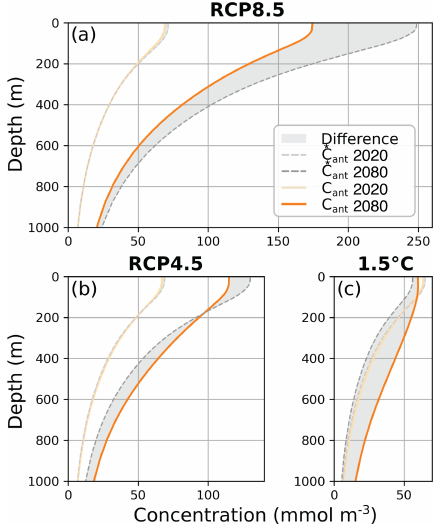
Figure 3. CESM global-mean anthropogenic carbon profiles ∗ C ant (z) (gray, dashed), for ( C ant (z) ) (orange, solid) and profiles of the (a) RCP8.5 scenario, (b) RCP4.5 scenario, and (c) 1.5 ◦ C sce- nario. The shaded region between the dashed and solid lines indi- cates the deviation from the historical scaling. Light lines are for 2020 and dark lines are for 2080. The shaded region between the lines is shown for zonal mean sections in Fig.